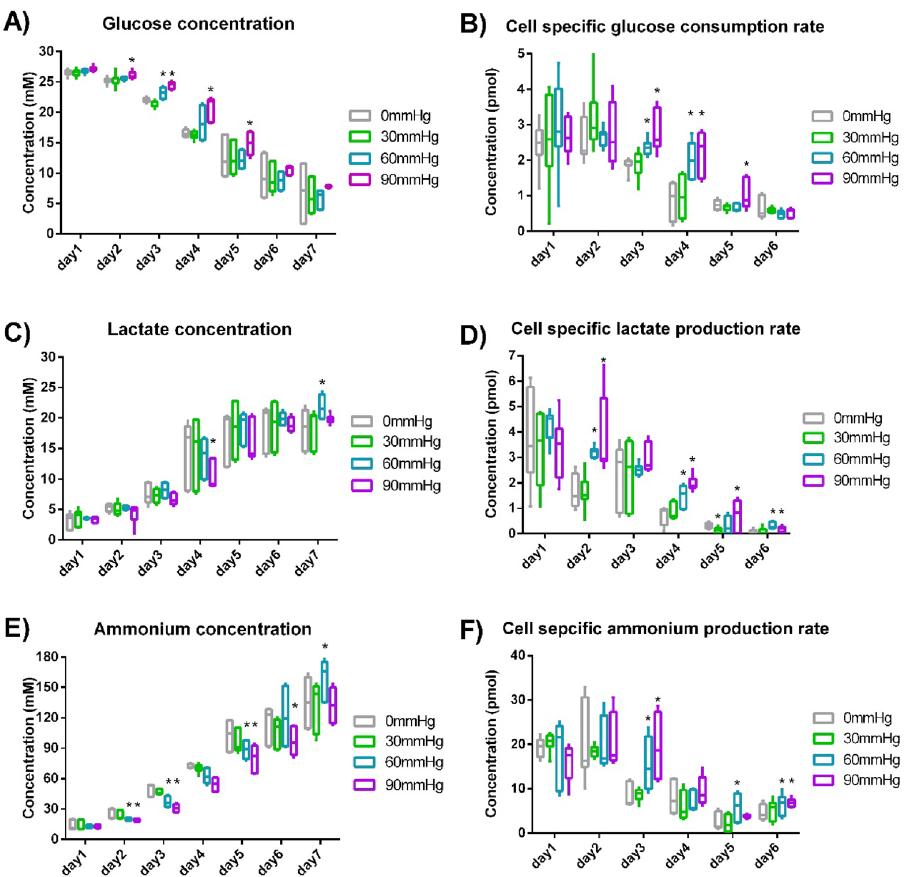
Figure 3. Metabolism of CHO cells. ( A ) Glucose concentration change. ( B ) Cell-specific glucose consumption rate. ( C ) Lactate concentration change. ( D ) Cell-specific lactate production rate. ( E ) Ammonium concentration change. ( F ) Cell-specific ammonium production rate. ( n = 3). *Indicates a statistically significant difference ( p < 0.05) when comparing with 0 mmHg